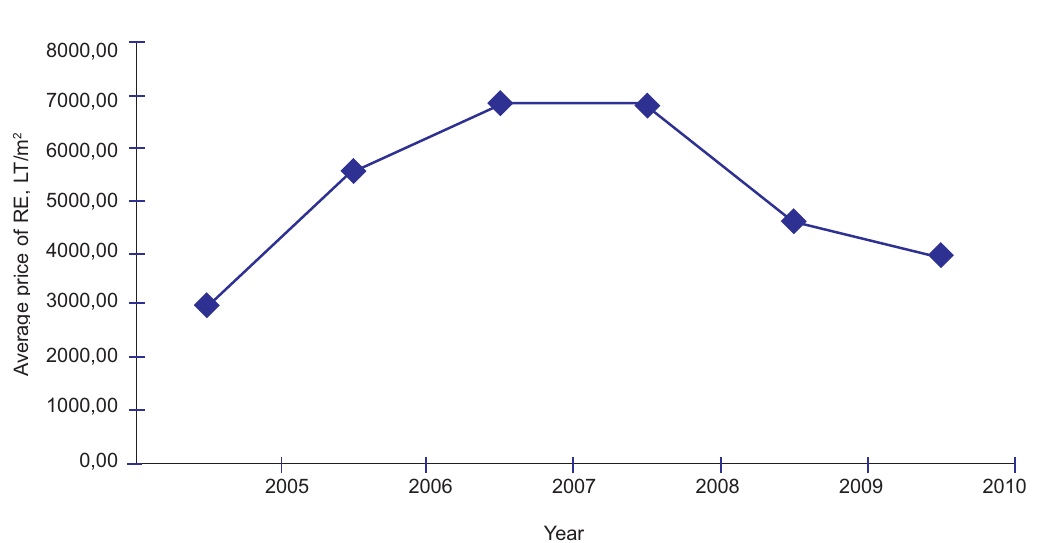
figure 3. average price of flats in Vilnius in 2005–2010 (JSC “ober-House” monitoring